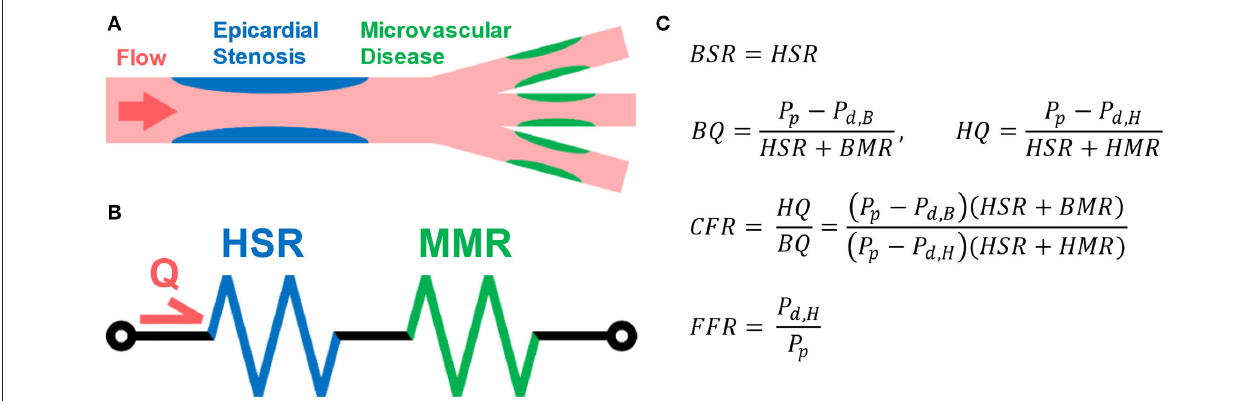
FIGURE 1 | Illustration of Coronary Flow Reserve (CFR). (A) Coronary arterial blood flow travels through both epicardial vessels and microvasculature. Each can contribute to the total resistance. The resistance due to the epicardial vessels (blue) is the stenotic resistance (SR), and the resistance due to the microvasculature (green) is the myocardial microvascular resistance (MMR). (B) The flow can be modeled using a circuit analogy in which the total resistance is the sum of the SR and MR. (C) MR during basal (BMR) and hyperemic (HMR) flow conditions should vary, but SR should remain the same in both (HSR). The basal flow rate (BQ) can be estimated as the difference in the proximal pressure (P p ) and distal, basal pressure (P d,B ) divided by the total basal resistance. Similarly, the hyperemic flow rate (HQ) can be estimated using the distal, hyperemic pressure (P d,H ) and total hyperemic resistance. CFR is defined as the ratio of HQ to BQ, while FFR is the ratio of P d,H to P p . Through these equations, the theoretical interdependence of CFR and FFR can be seen.